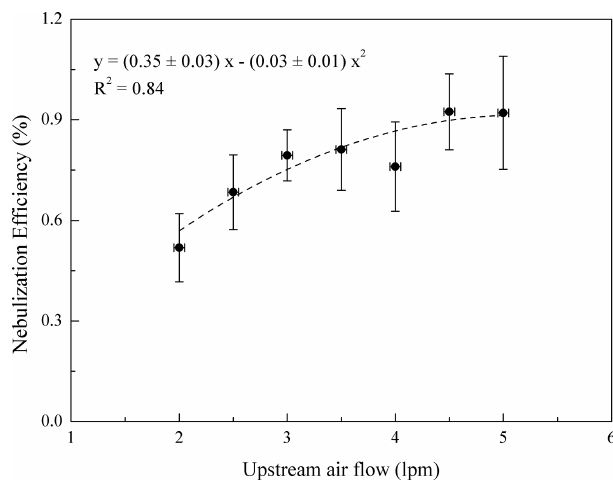
Figure 5. Collison nebulization efficiency (percentage values) vs. upstream air flow.